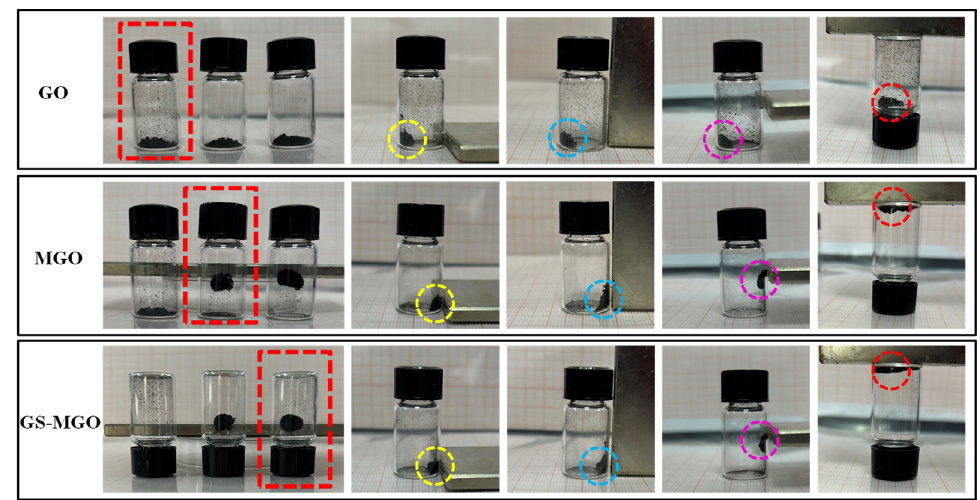
Figure 3. Magnetic performance of GO, MGO, and GS-MGO.